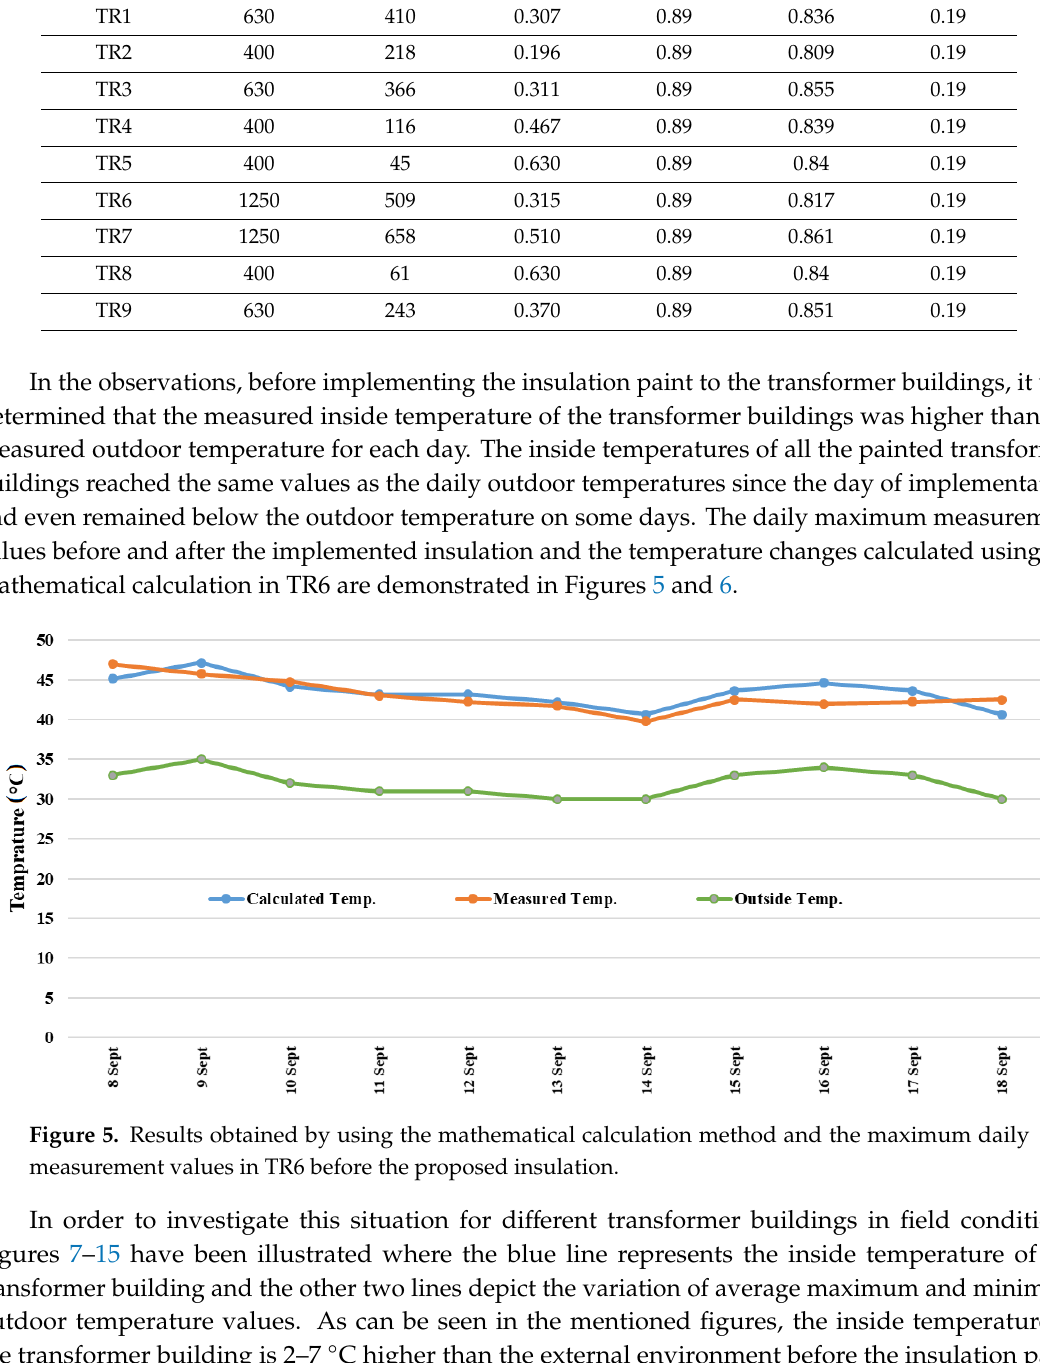
Figure 5. Results obtained by using the mathematical calculation method and the maximum daily measurement values in TR6 before the proposed insulation.